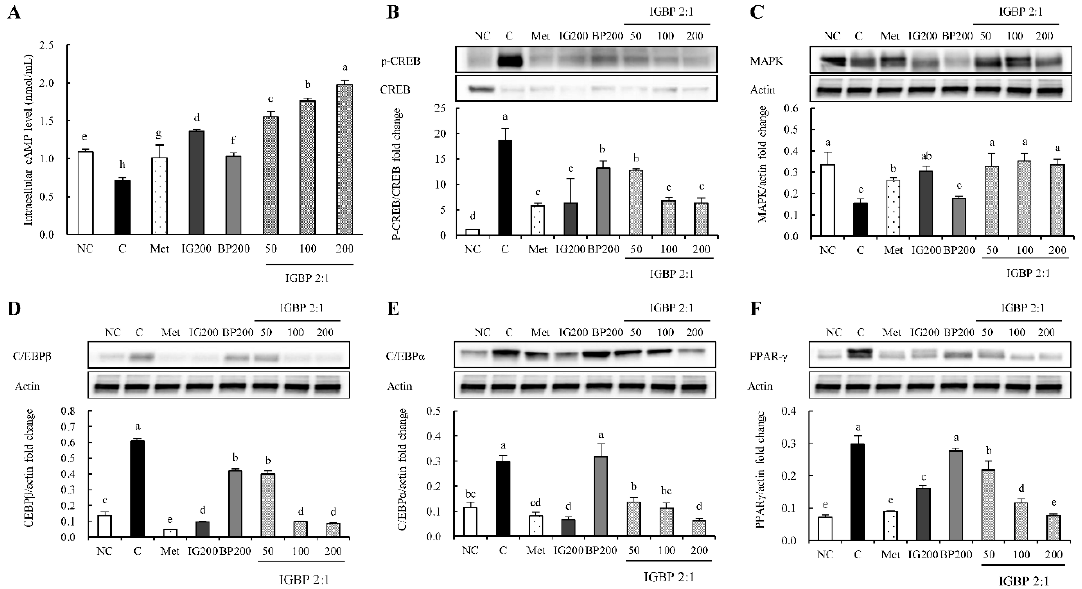
Figure 1. Effects of the IGBP 2:1 mixture on the adipogenesis mechanism in 3T3-L1 adipocytes: ( A ) cAMP level (ELISA), ( B ) p-CREB/CREB expression ratio (Western blotting), ( C ) MAPK expression (Western blotting), ( D ) C/EBP β expression (Western blotting), ( E ) C/EBP α expression (Western blotting), and ( F ) PPAR γ expression (Western blotting). NC, normal control; C, differentiated control; Met, metformin 1 mM; IG200, IG 200 μ g/mL; BP200, BP 200 μ g/mL; IGBP 2:1 (50, 100, or 200 μ g/mL). The resulting values are shown as mean ± standard deviation (SD; n = 3), and the different superscript letters (alphabet) indicate significance at p < 0.05.